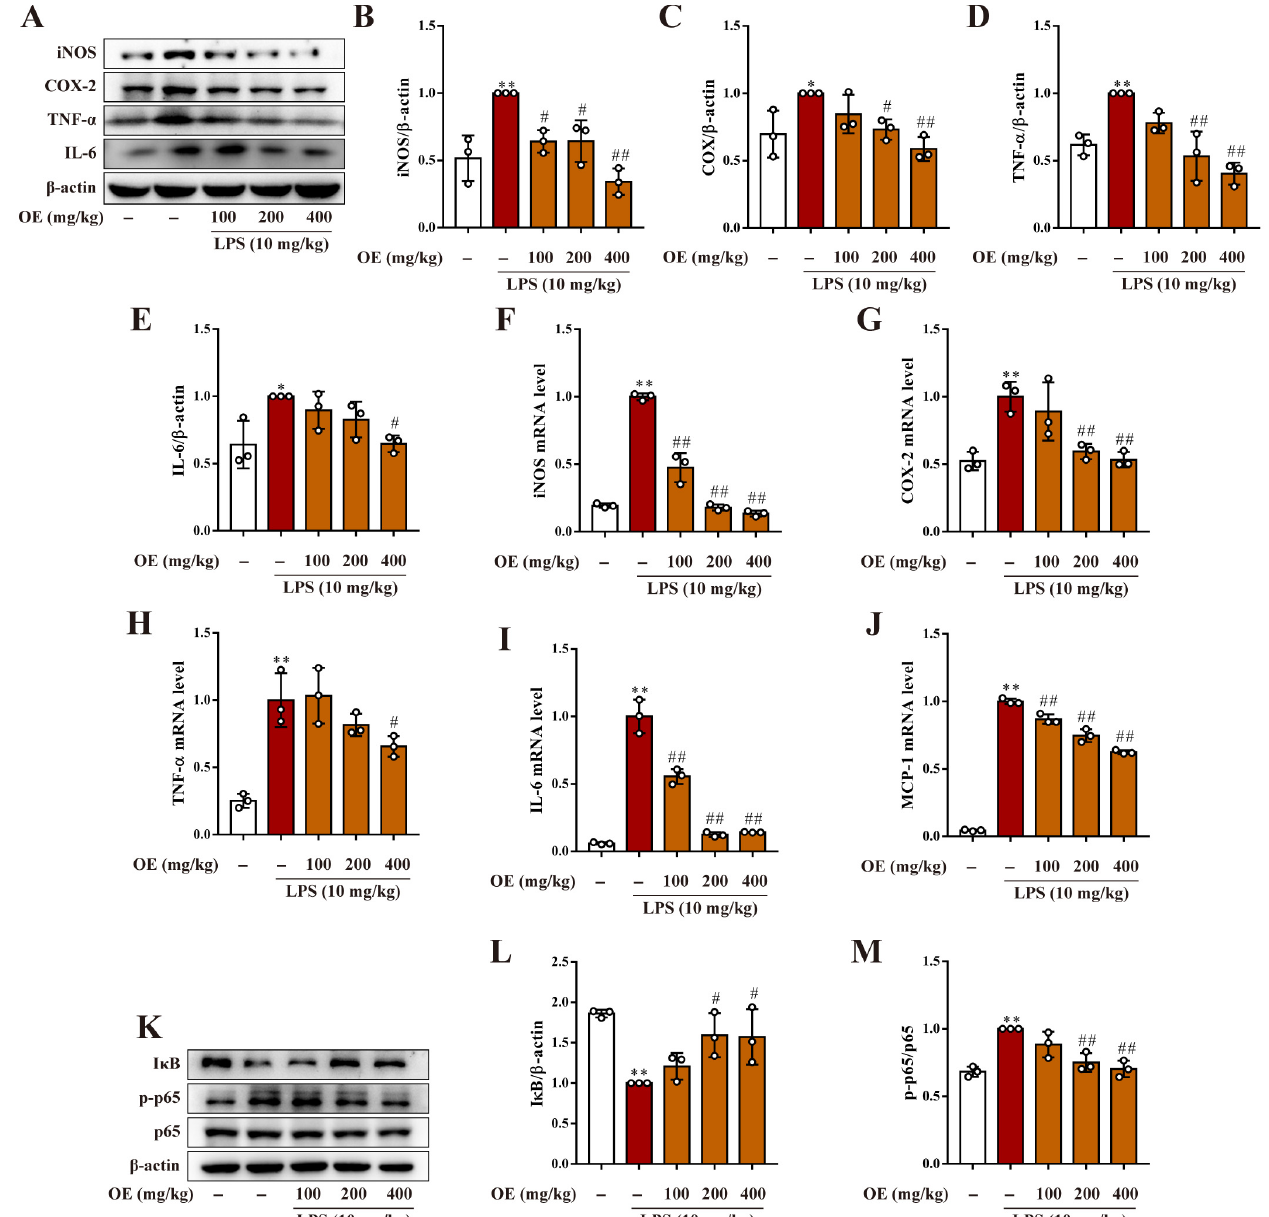
Figure 7. OE exhibited anti-inflammatory activity in AKI mice. ( A – M ) Mice were administered OE (100, 200, 400 mg/kg) by gavage for 7 days followed by the intraperitoneal injection of LPS (10 mg/kg) and feeding for another 12 h. The total protein expression of iNOS, COX-2, TNF- α , and IL-6 ( A – E ) in mice kidneys was determined by a western blotting assay. The mRNA level of iNOS (F), COX-2 (G), TNF- α ( H ), IL-6 ( I ), and MCP-1 ( J ) in mice kidneys was determined by quantitative real time PCR analysis. The protein expression level of I κ B, p-p65, and p65 in mice kidneys was determined by a western blotting assay. Data presented as Means ± SD. * p < 0.05, ** p < 0.01 vs. control group; # p < 0.05, ## p < 0.01 vs. LPS group; ns, no significance.